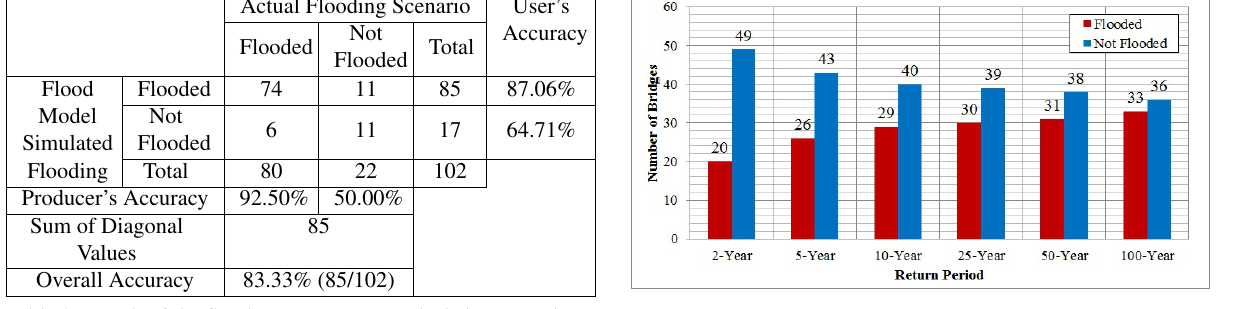
Figure 11: Number of flooded bridges for each of the 6 extreme rainfall events.